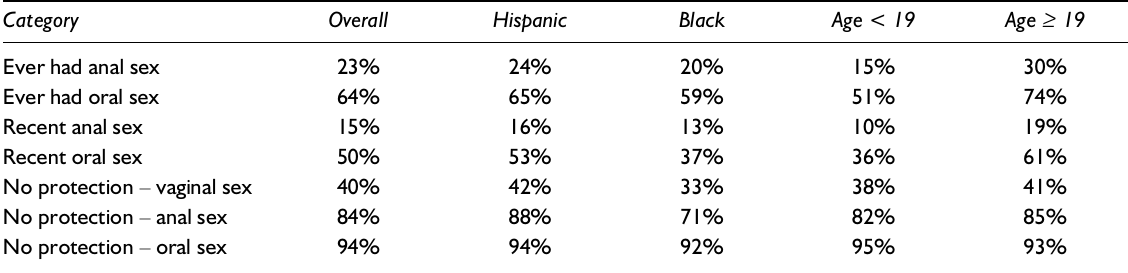
Table 1 Pattern of sexual activity in study